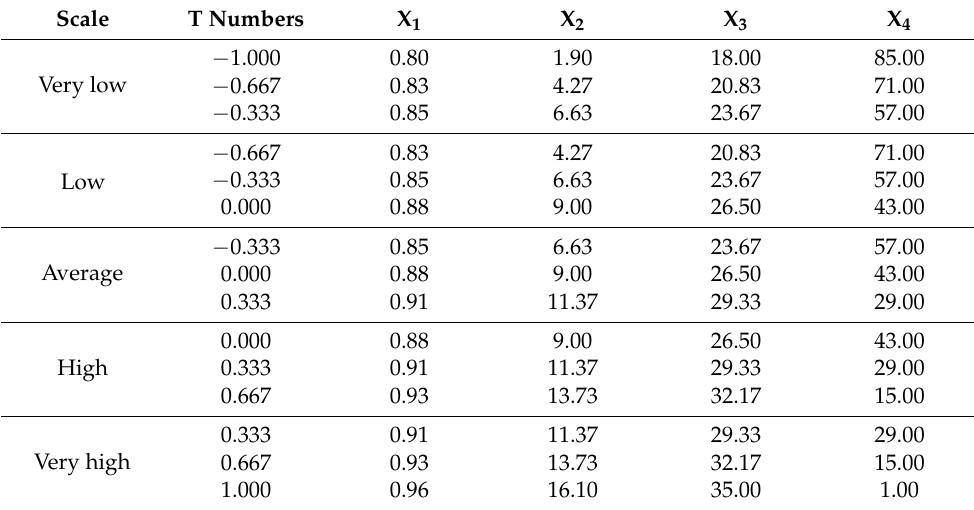
Table 5. Range of definition for the factors, sets of values, and triangular numbers of Y 1 indicators for Saint